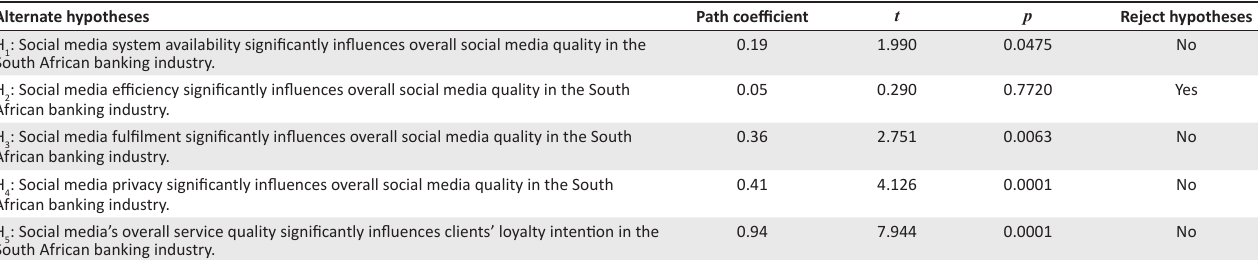
TABLE 2: Relationships between E-SOCIAL-SERVQUAL variables and client loyalty intentions. Alternate hypotheses Path